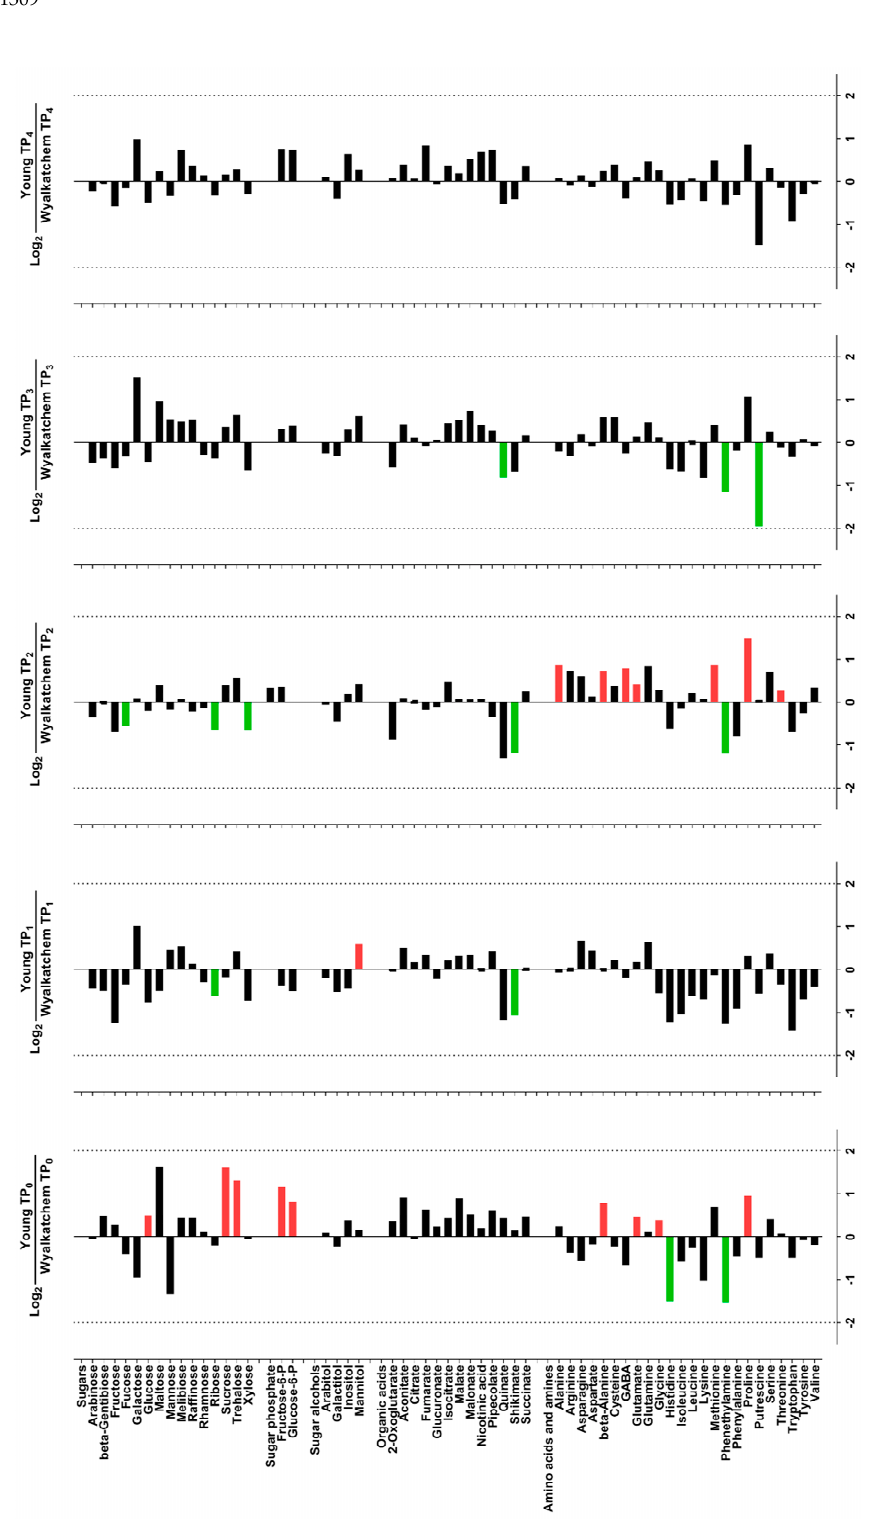
Figure 3. Log 2 -fold changes of primary metabolites in spikes of cold-tolerant Young (Y) compared to cold-sensitive Wyalkatchem (W) at each time point. Fold changes were calculated by dividing the concentration of Young by the concentration of Wyalkatchem at each time point, followed by log 2 -transformation. FDR-adjusted p -value of 0.05 was set as the cut-off. Green = significantly lower in Young, or higher in Wyalkatchem; red = significantly higher in Young, or lower in Wyalkatchem. n = 3.